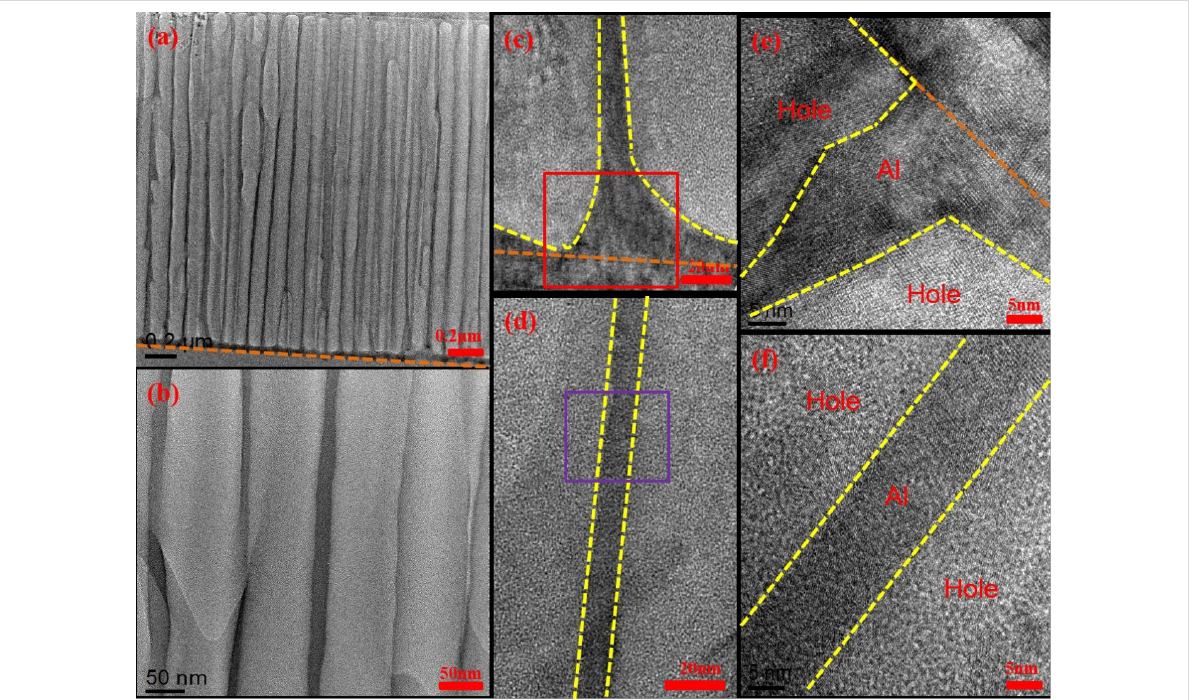
Figure 4: Transmission electron microscopy measurements for sample AAO70 obtained at different magnifications: (a) complete pores exist at the sapphire substrate; (b) a magnified view of (a); (c, d) magnified views of the areas between the pores shown in (a); (e) magnified view of the red area in (c); and (f) magnified view of the purple area shown in (d).